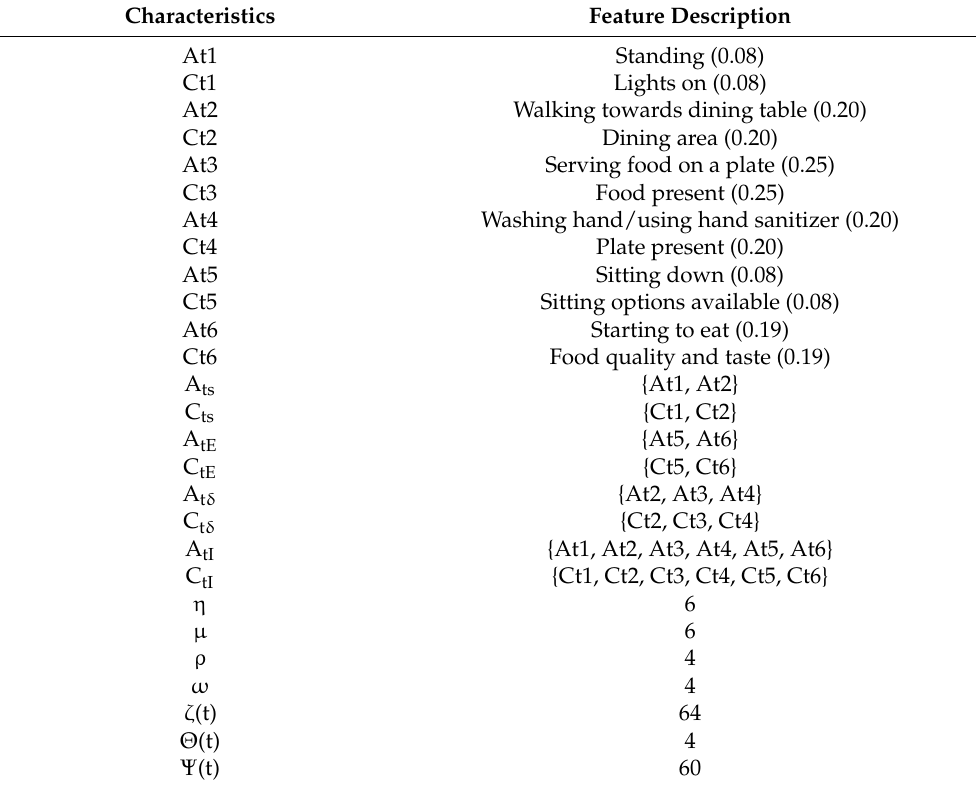
Table 1. Determining the different characteristics of a typical complex activity—eating